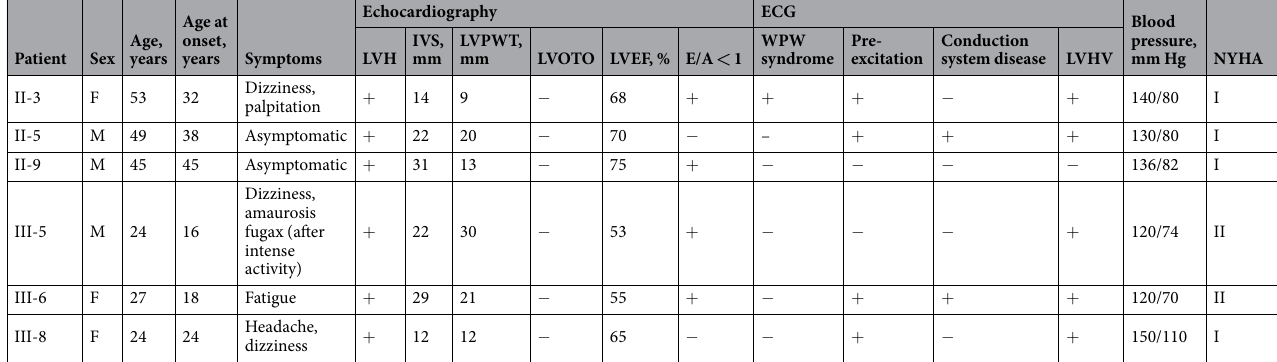
Table 1. Clinical characteristics of affected members in the current family with PRKAG2 syndrome. F, female; M, male; LVH, left ventricular hypertrophy; IVS, interventricular septum; LVPWT, left ventricular posterior wall thickness; LVOTO, left ventricular outflow tract obstruction; LVEF, left ventricular ejection fraction; WPW syndrome, Wolff-Parkinson-White syndrome; LVHV, Left ventricular high